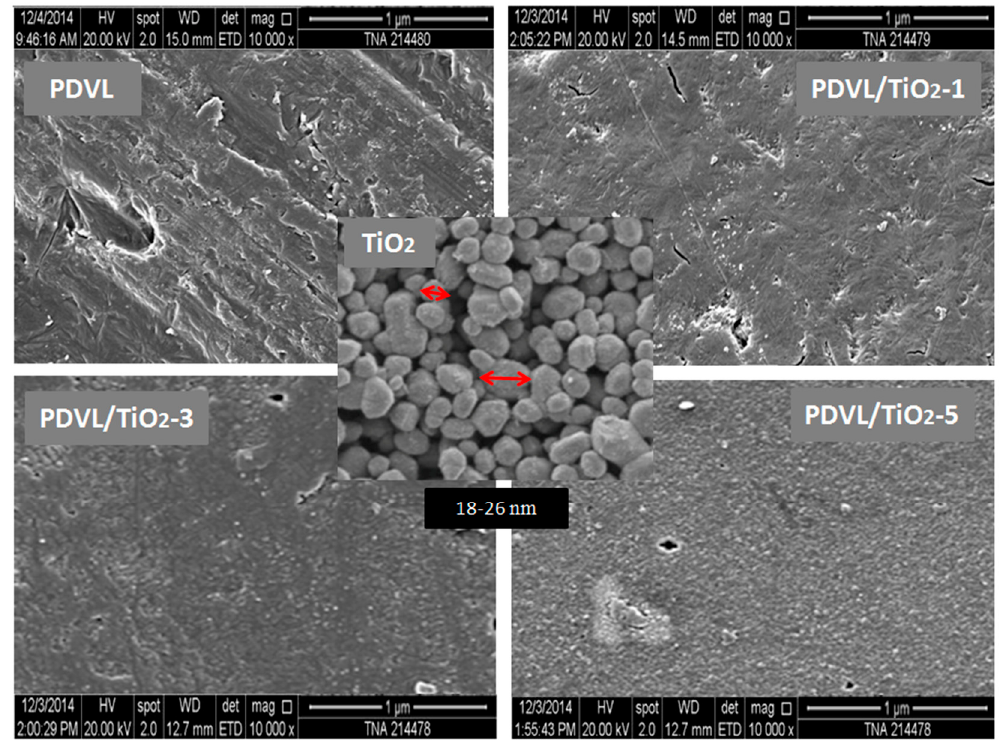
Figure 2. SEM micrographs of the surface morphologies of pure PDVL and PDVL/TiO 2 nanocomposites containing 1, 3, and 5 wt % TiO 2 contents.